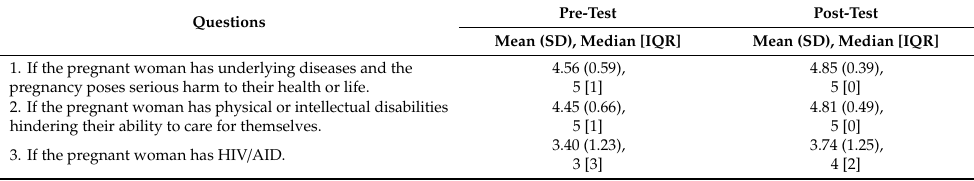
Table 5. The comparison of the pre- and the post-test responses to the examples of abortion scenarios ( n =